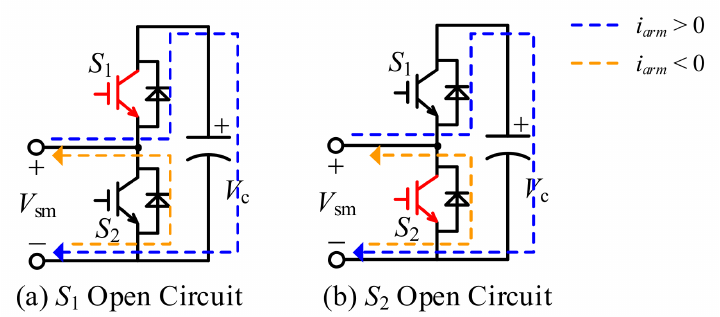
Figure 2. The charging and discharging current circuit of the fault submodule.